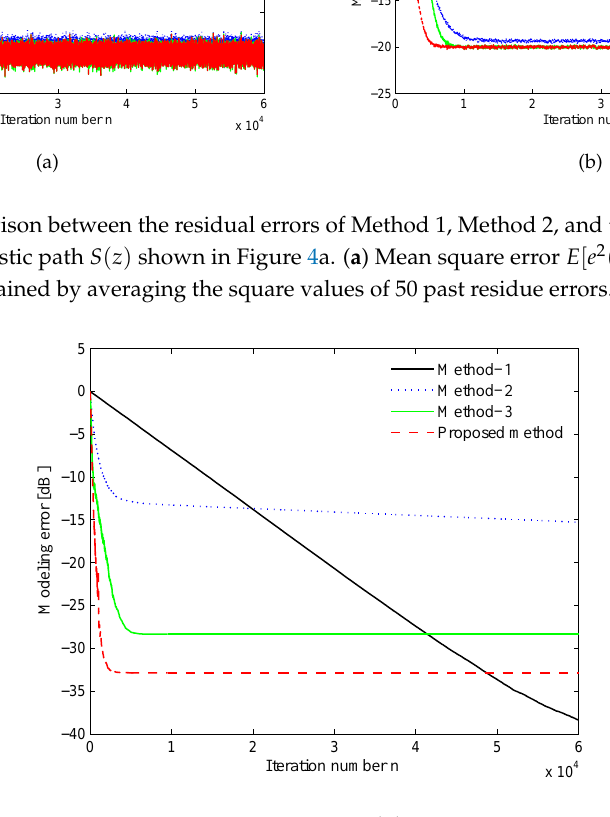
Figure 7. Comparison between the modeling errors (cid:52) S ( n ) of Method 1, Method 2, and the proposed method for the fixed acoustic path S ( z ) shown in Figure 4a.